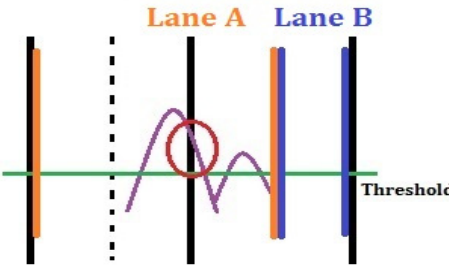
Figure 9. The result of handling the case shown in Figure 5 using the proposed method 1.